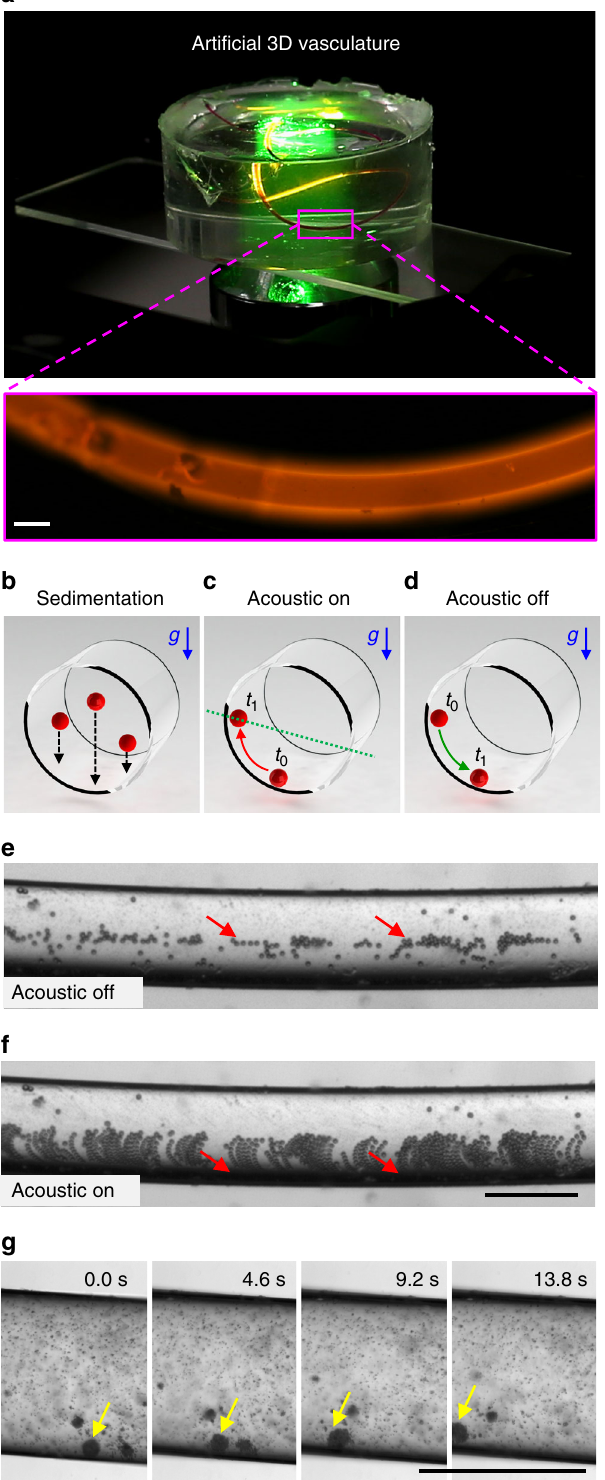
Fig. 6 Propulsion in a circular cross-sectional arti fi cial vasculature. a The image represents a three-dimensional PDMS-based arti fi cial vasculature with a circular cross section. The inset shows the fl uorescently labelled channel. b The particles sediment vertically downward towards the nearest surface and then slowly roll down to the bottom of the channel due to gravity. c Particles roll up along the circular channel from state t 0 to t 1 in the presence of acoustic waves. The green dashed line in c represents the maximum height particles can reach. d Particle rolls down along the surface, from state t 0 to t 1 in the absence of acoustic waves. e The micrograph shows that particles aligned at the bottom of the channel in the absence of the acoustic waves. f Image sequence demonstrates the particles migration is moving upwards along the channel in the presence of the acoustic fi eld, see also Supplementary Movie 8. g Rolling motion is executed in a circular channel, see also Supplementary Movie 9. All